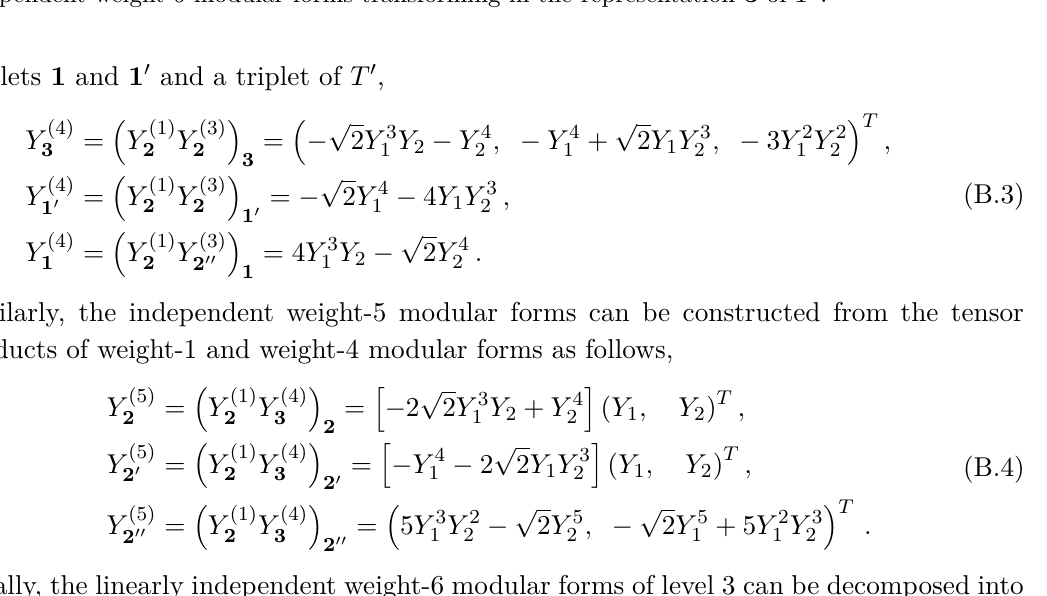
and Y (6) stand for two linearly 3 I 3 II